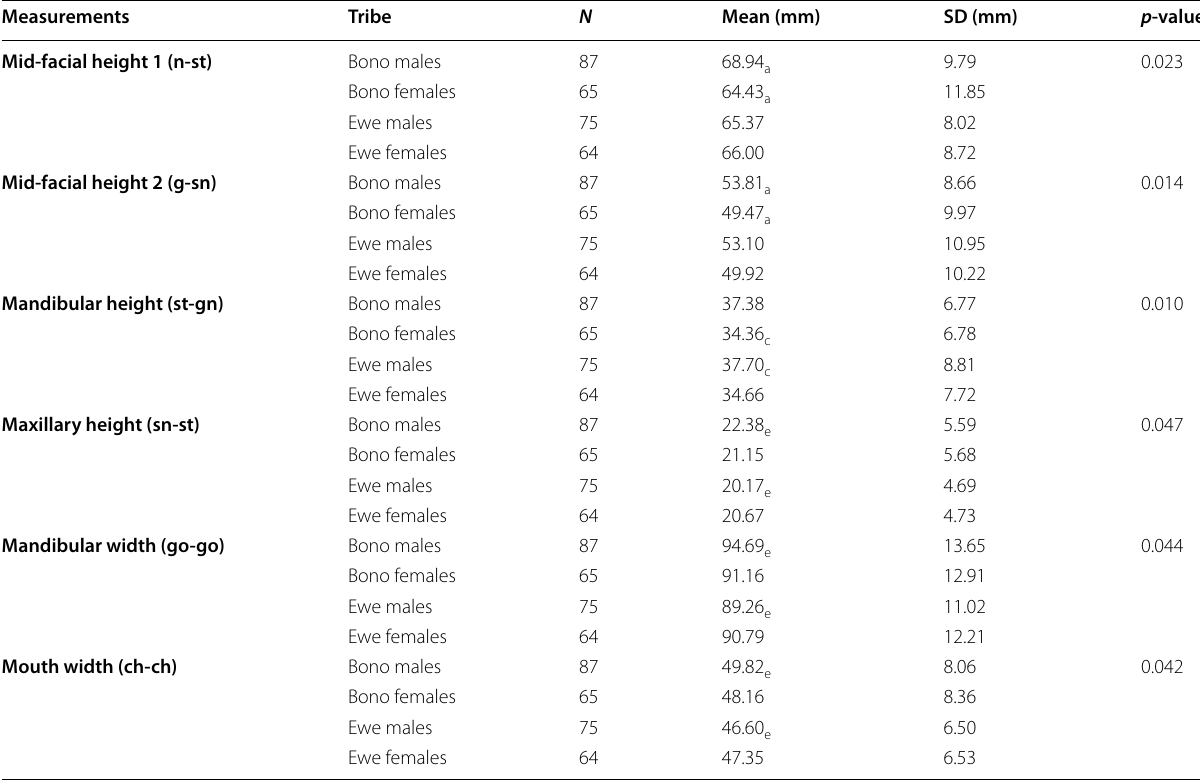
Table 3 Analysis of variance of morphological facial measurements of Bono and Ewe